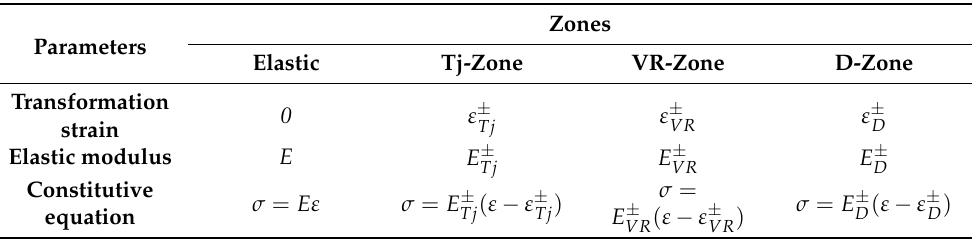
Table 1. Material parameters and constitutive equations related to each zone in tension and compres- sion during